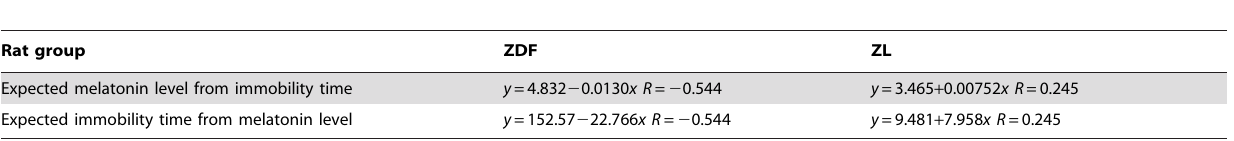
Table 3. Correlations between plasma melatonin concentration and immobility time in FST.